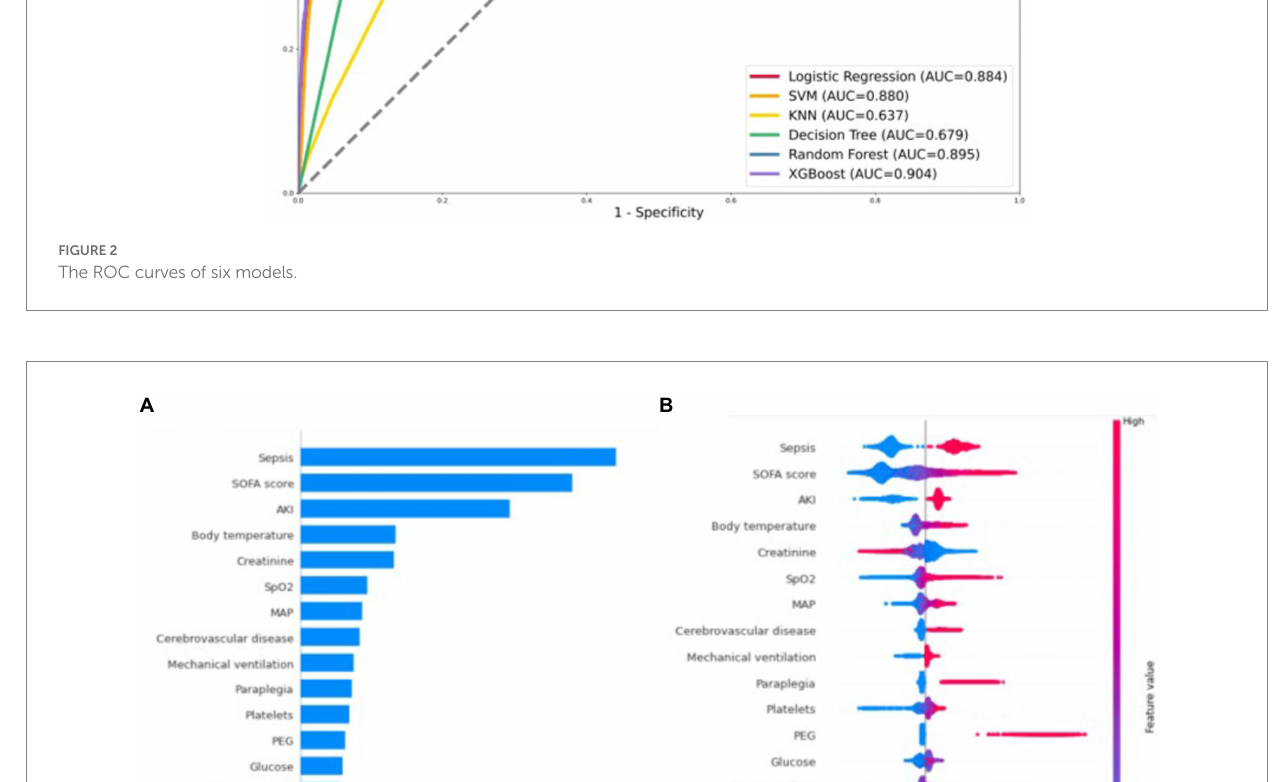
FIGURE 3 SHAP summary plot for the first 20 clinical features contributing to the XGBoost model. (A) The ranking of importance features in the XGBoost model. The matrix of SHAP summary plot describes the importance of each features in the development of the XGBoost model. (B) The attribute of each feature in the final model. The horizontal coordinate represents the SHA p value. Each line indicates a feature, and the high and low feature values are shown in red and blue, respectively. SOFA, sequential organ failure assessment; AKI, acute kidney injury; SpO2, oxygen saturation; MAP, mean arterial pressure; PEG, percutaneous endoscopic gastrostomy; PT, prothrombin time; SHAP, SHapley Additive